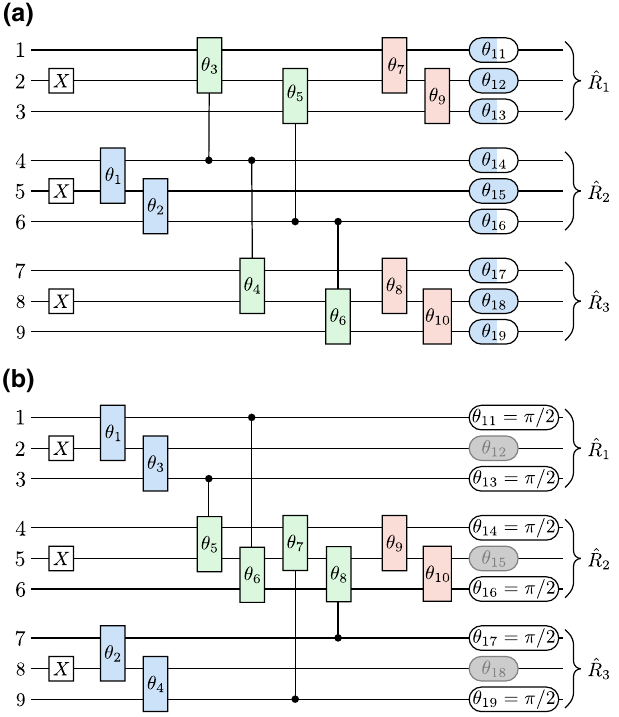
FIG. 6. VQE circuits for preparing the ground state of a pla- quette with periodic boundary conditions. Gate definitions are given in Fig. 4. Gates of the same color in each circuit share a variational parameter after eliminating redundant parameters. The half-shaded gates include an offset of + π/ 2 added to the shared parameter, while the gray-shaded gates can be eliminated entirely. The circuit for (a) the electric representation of the Hamiltonian and (b) for the magnetic